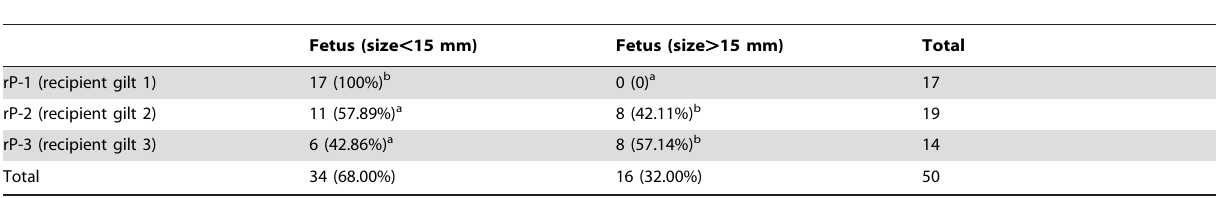
Total 50 a,b Different superscripts within a column are significantly different, a , b; P , 0.05.